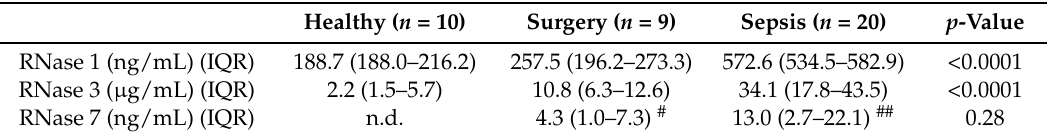
Table 2. Serum Levels of